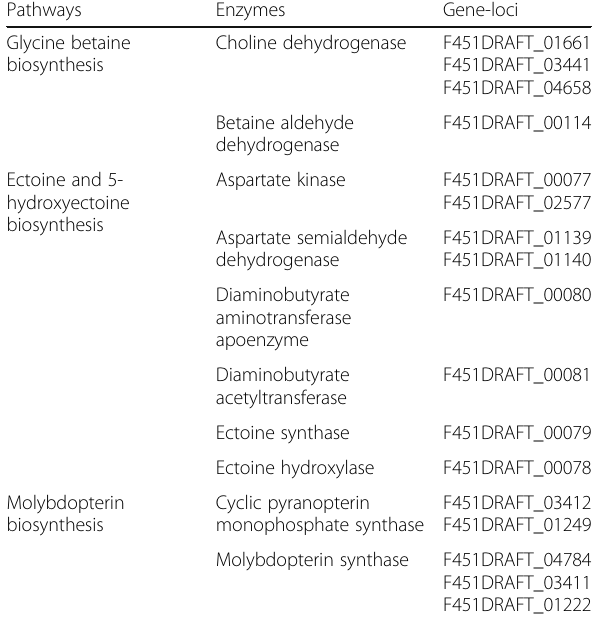
Table 5 Enzymes and gene-loci participating in selected pathways identified in the draft genome of M. rhizophilum CL-YJ9 T . Gene-loci are from the IMG/MER